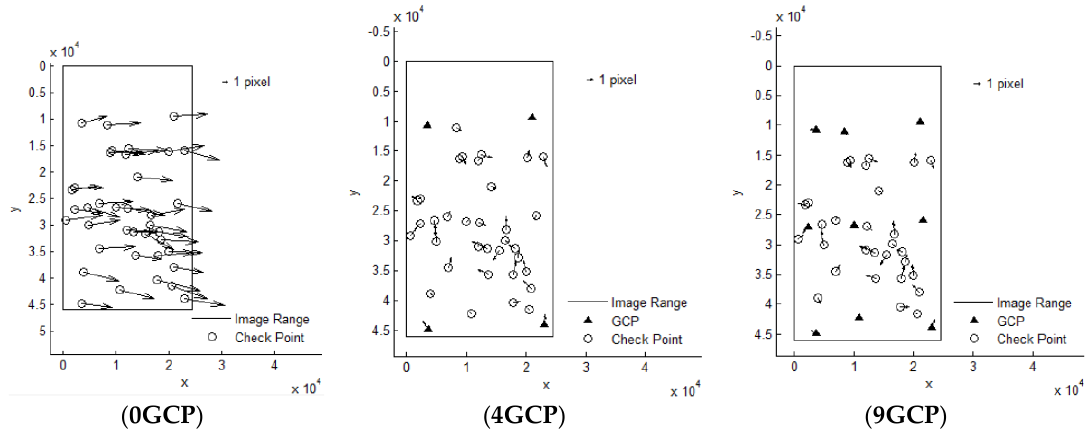
Figure 7. Residual distributions of check points of orientation for ZY-3.